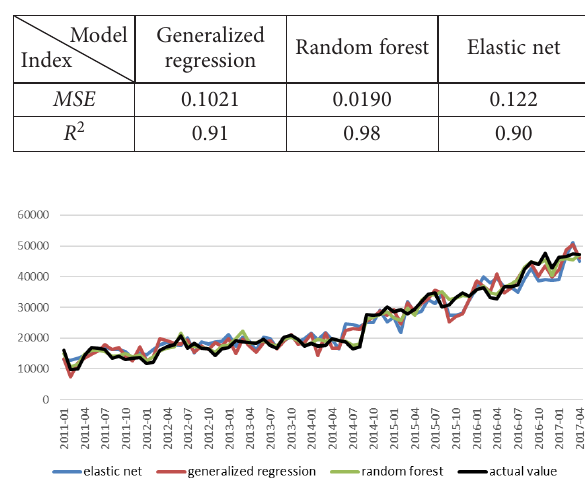
Figure 4. The trends between real and fitted housing